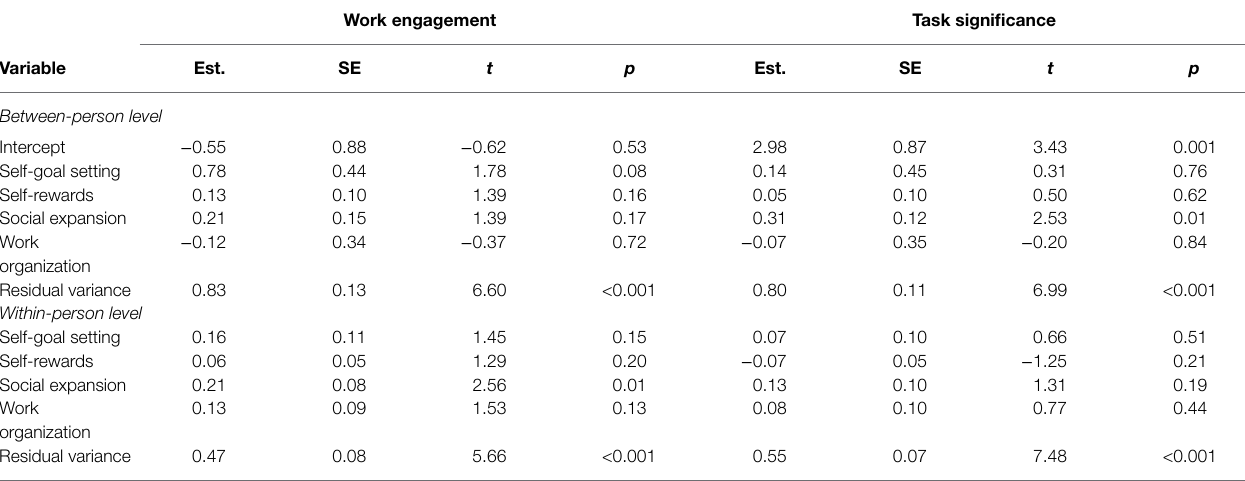
TABLE 3 | Unstandardized coefficients from multilevel path modeling predicting work engagement and task significance. Work engagement Task